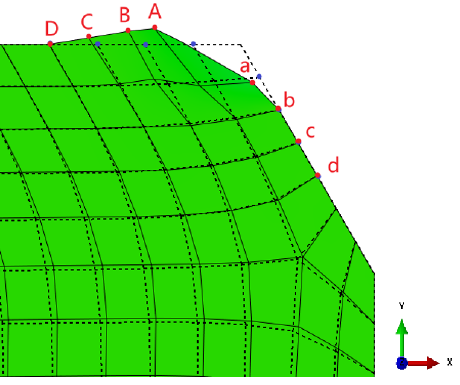
Figure 12. Deformation of the slab corners under horizontal rolling with a chamfered length of 20 mm.